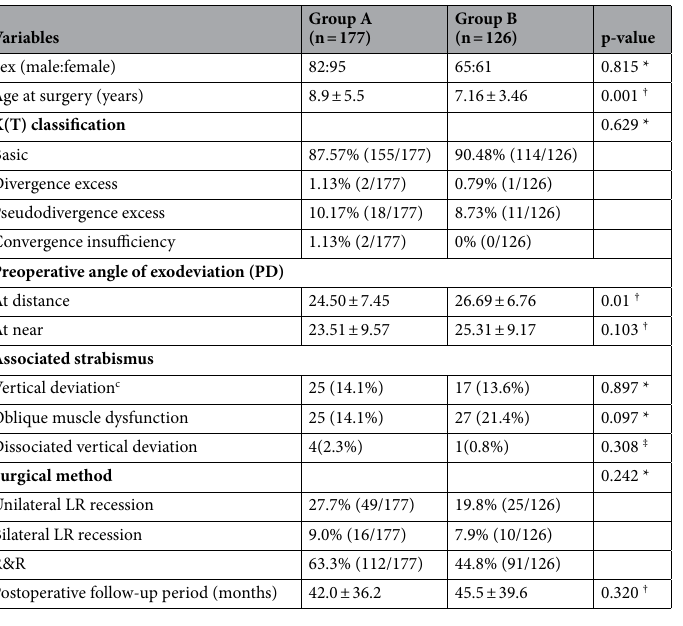
Table 2. Demographic data of the patients in groups A and B. Group A = alignment between 10 PD exodeviation and 5 PD esodeviation at the last follow-up; Group B = residual or recurrent exotropia defined as exodeviation > 10 PD at last follow-up; X(T) = intermittent exotropia; PD = prism dioptres; LR = lateral rectus; R&R = unilateral lateral rectus recession and medical rectus resection. * Chi-square test. † Independent T-test. ‡ Fisher’s exact test. †